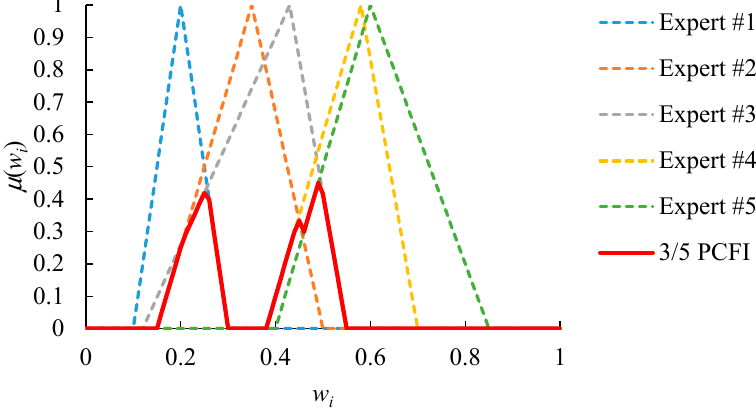
Figure 6. The partial consensus among any three experts in the previous example.